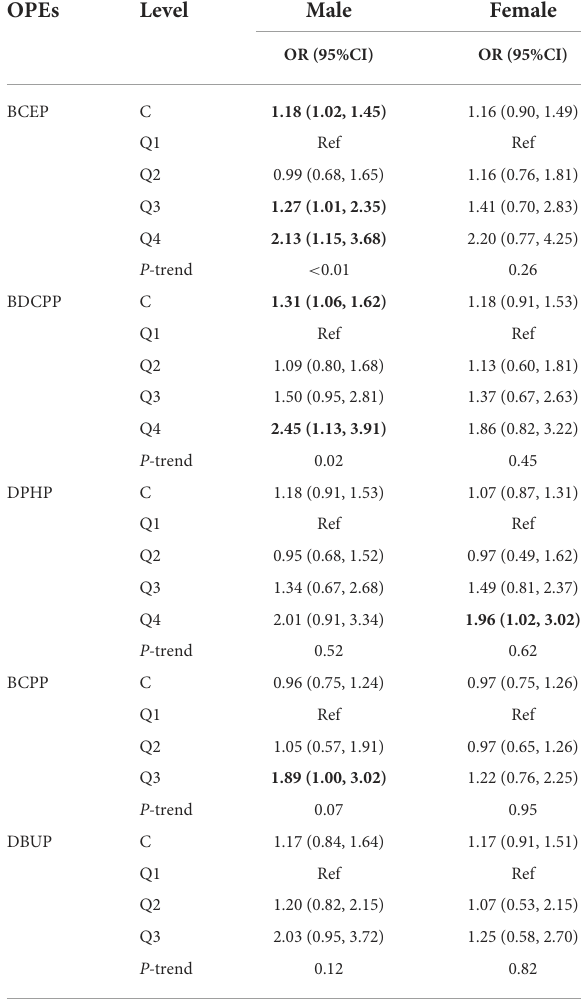
TABLE 3 Associations of OPE metabolites with NAFLD in all men and women.